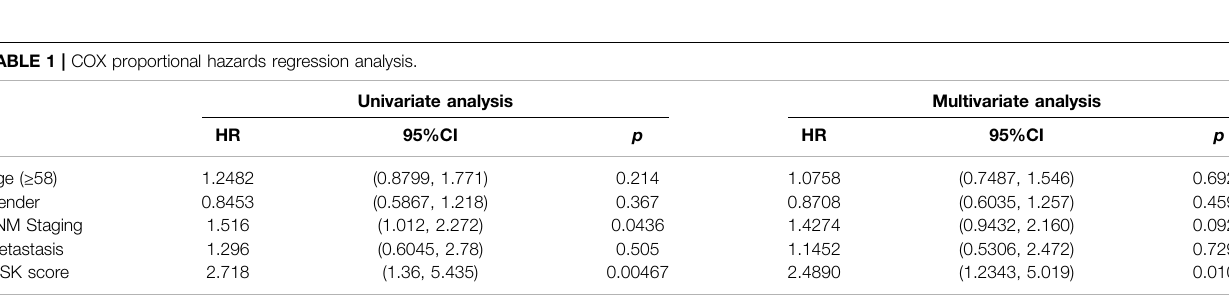
TABLE 1 | COX proportional hazards regression